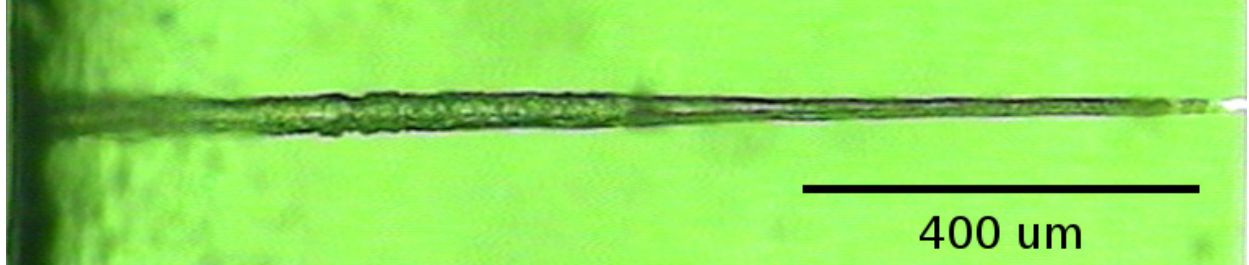
Figure 4. Microchannel with L/D ≈ 25 and L ≈ 1.2 mm obtained following the procedure in Section 2.2 with a 2 min etching time. The image has been taken under polarized light (the channel is black and the irradiated silica is